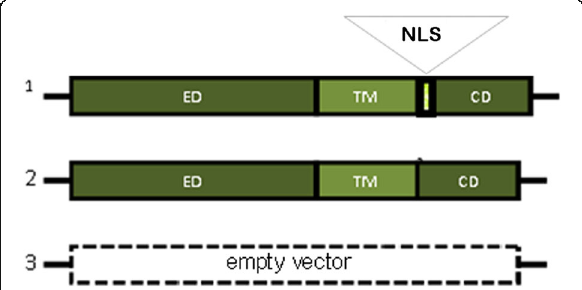
Fig. 10 Plasmid constructs used for transfection. ( 1) Full length syndecan-1 (FLs1); ( 2 ) Syndecan-1 that lacked the nuclear localization signal (NLSdel); and ( 3 ) Empty vector control (V). ED = ectodomain, TM = transmembrane domain, CD = cytoplasmic